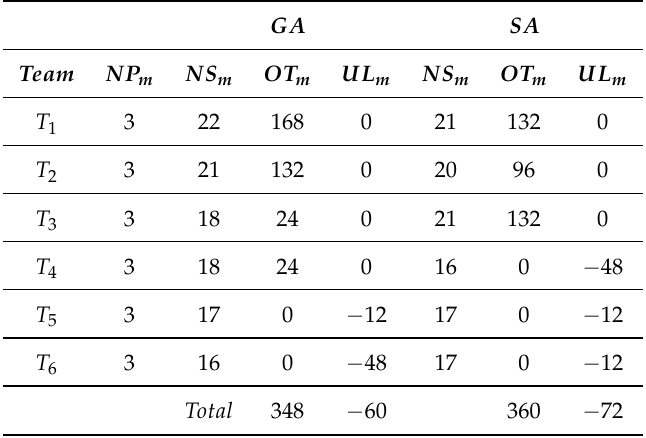
Table 11. Analysis of the GA and SA physician schedule for September.